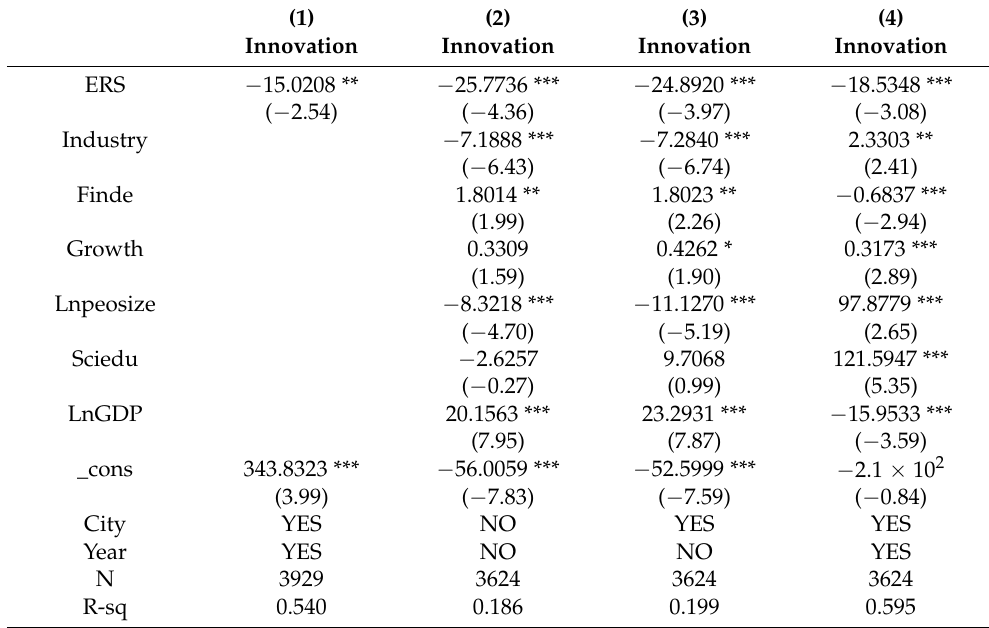
Table 3. Baseline regression